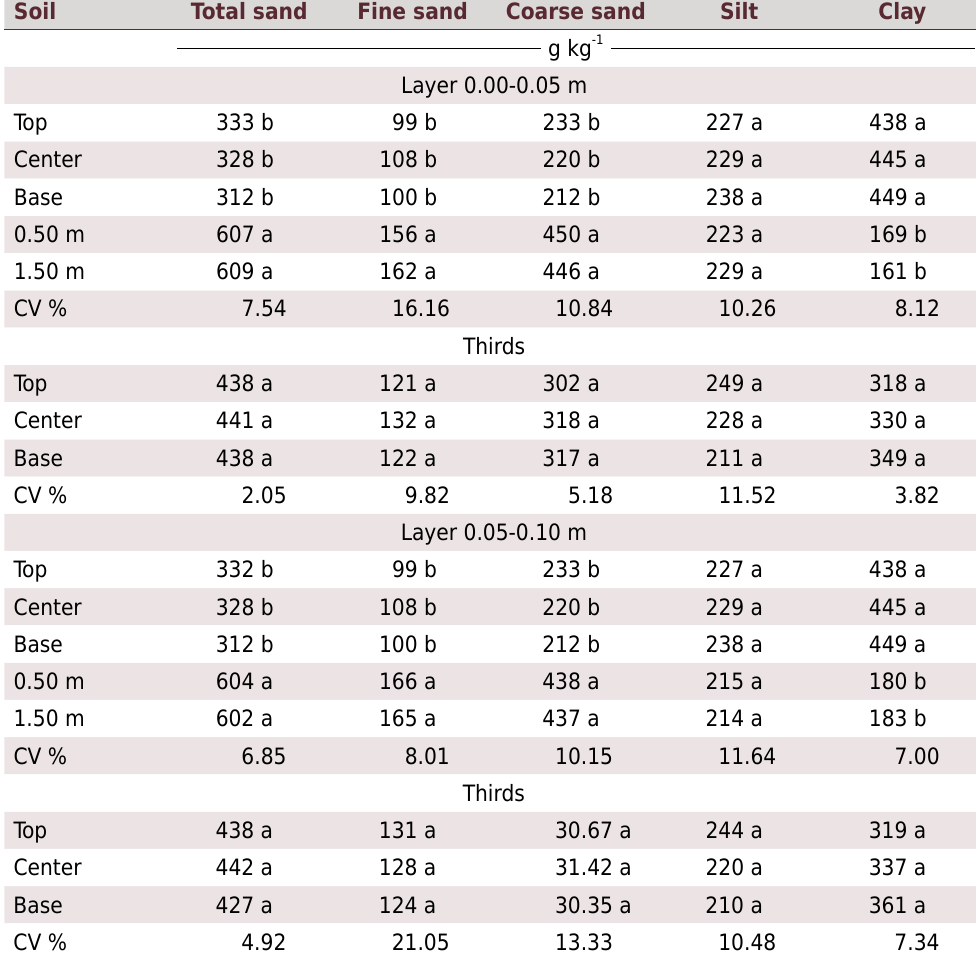
Table 2. Textural composition of termite mounds and their adjacent soils, in the Mar de Morros region, municipality of Pinheiral, Rio de Janeiro State Soil Total sand Fine sand Coarse